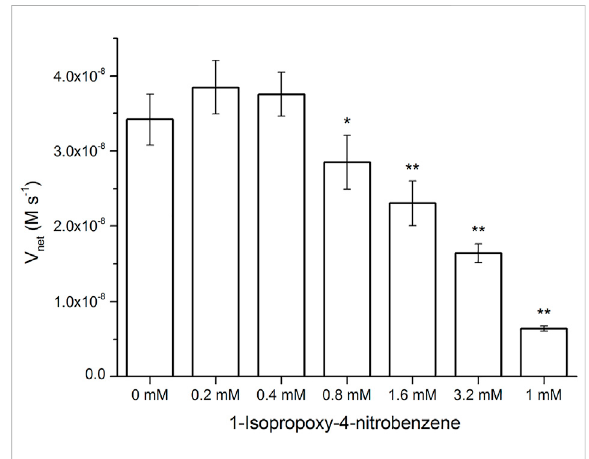
FIGURE 4 Hydrolysis rate of 0.2 mM of p-nitrophenyl esters with alkyl groups of various length (C2 to C14) by 0.1 mM of RADA16H 2 at 25 ° C. * p < 0.001 vs. pNPA and # p < 0.001 vs. pNPB,